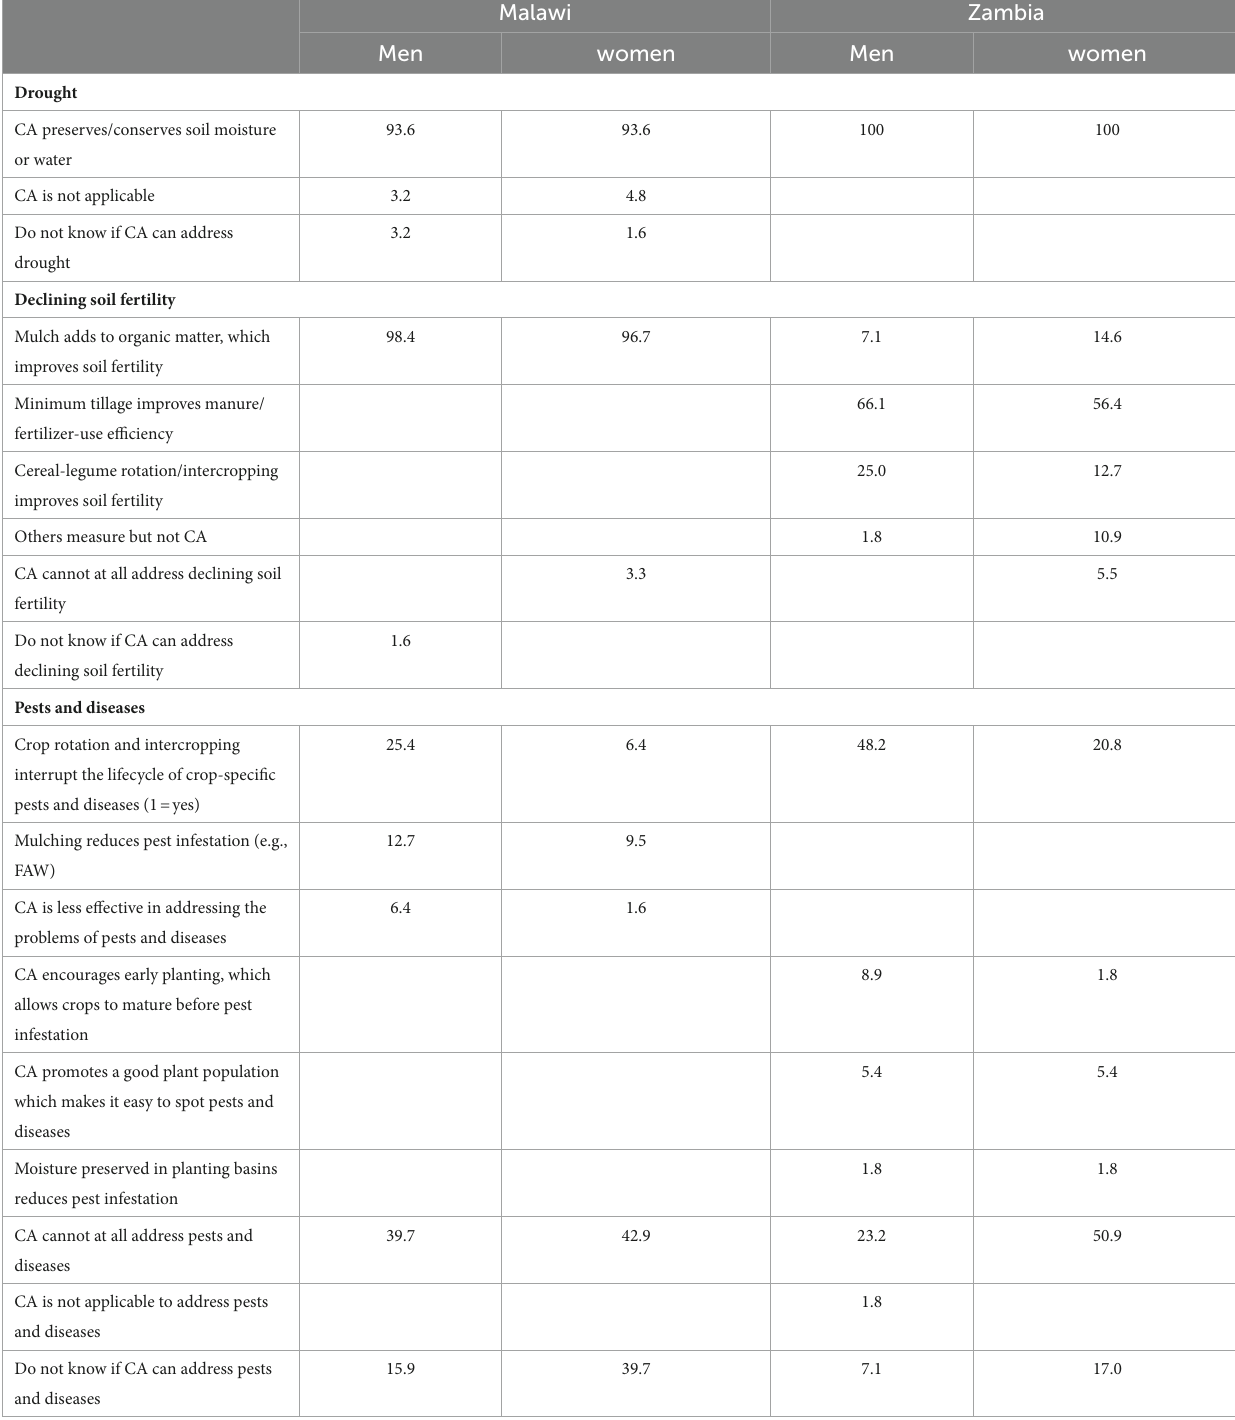
TABLE 4 Perception on how CA addresses crop production constraints by gender (% of focus